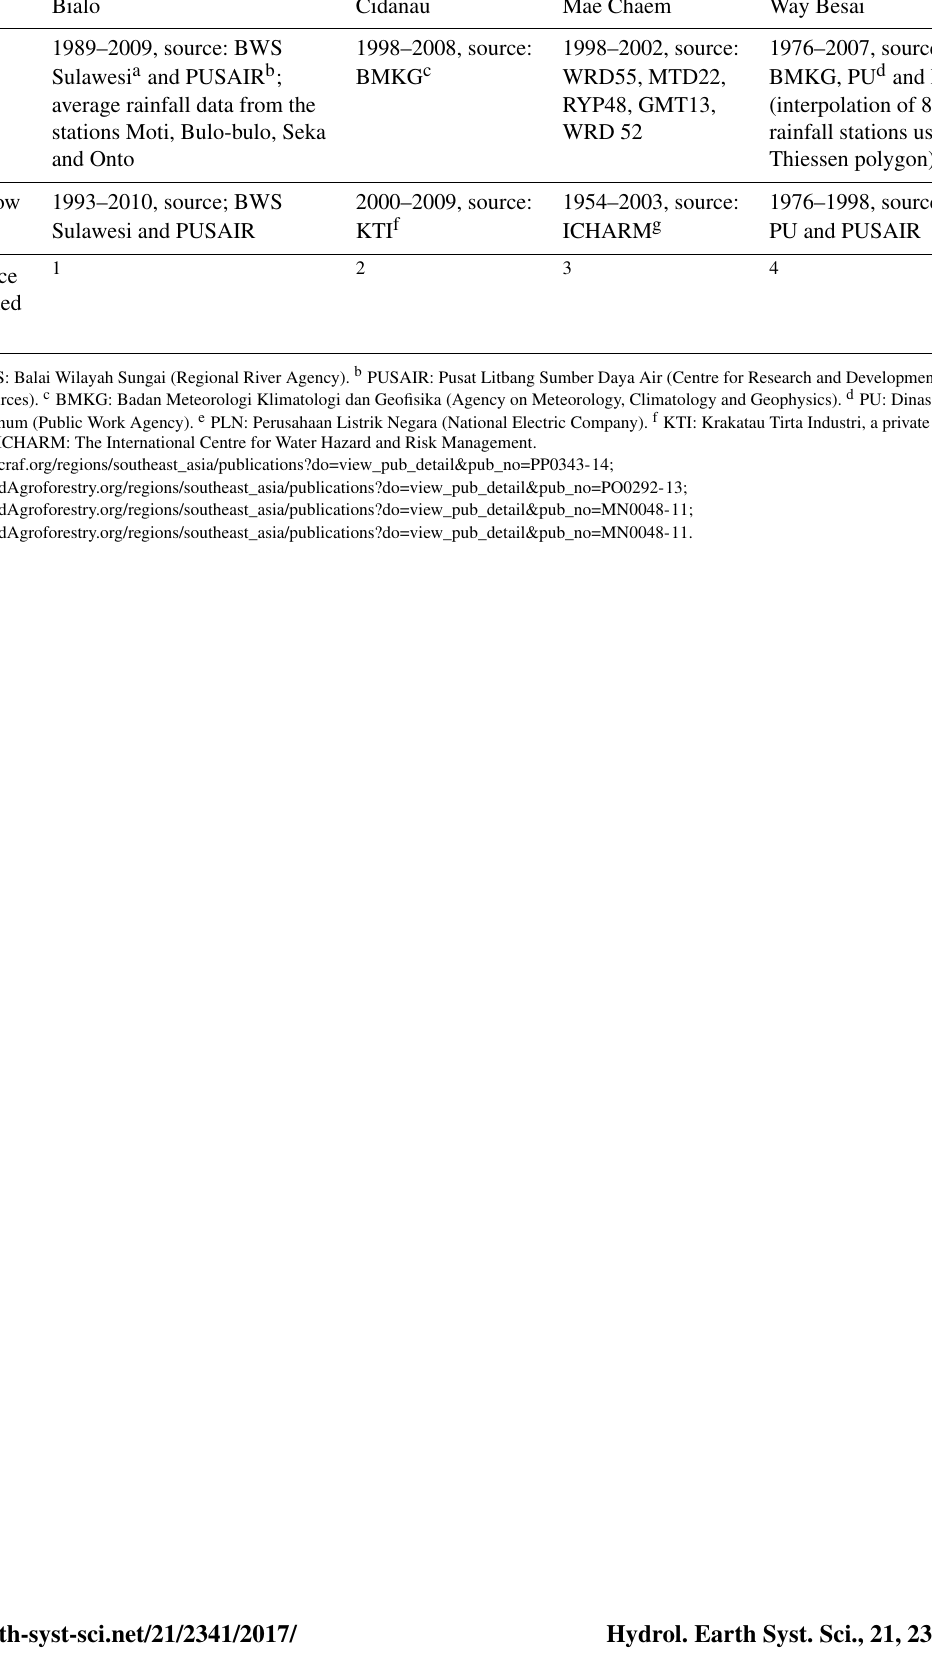
Table A1. Data availability. Bialo Cidanau Mae Chaem Way